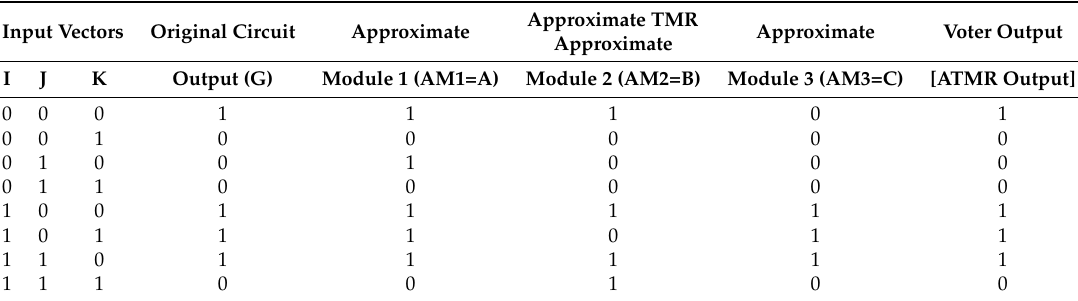
Table 1. Approximate TMR: An